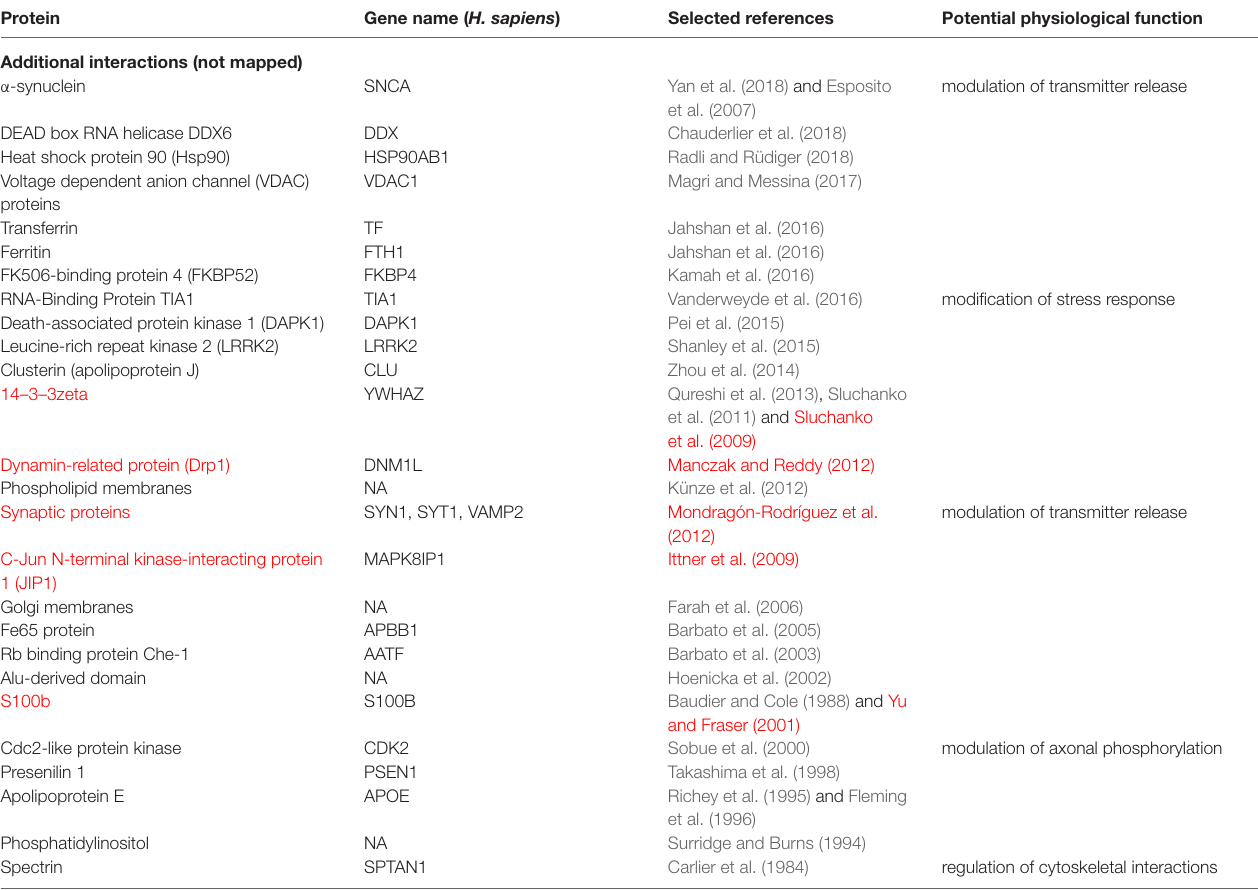
TABLE 1.2 | Additional binding partners, whose interactions have not been mapped to tau specific regions.